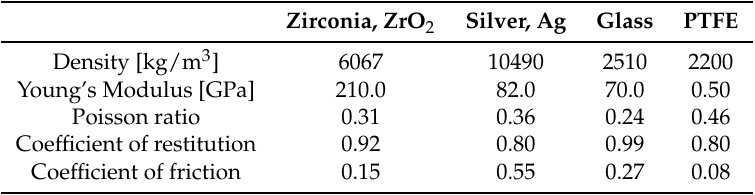
Table 2. Model parameters and material properties (adapted from